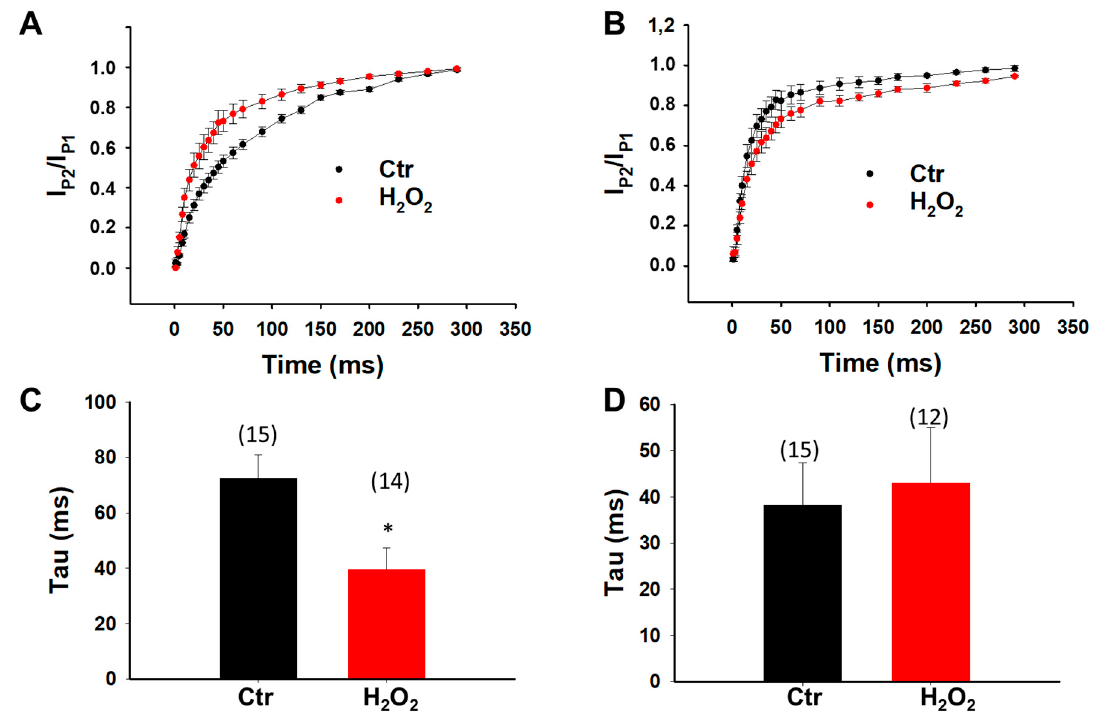
Figure 11. Effects of H 2 O 2 on recovery of sodium channels in hiPSC-CMs from donor and BrS- patient. Cells were treated with vehicle (Ctr) or H 2 O 2 (200 μ M) for 2 h. ( A ) Recovery curves of peak sodium channel currents (I Na ) recorded in hiPSC-CMs from the D2 healthy donor. ( B ) Recovery curves of peak I Na recorded in SCN10A-hiPSC-CMs. ( C ) Mean values of time constants (Tau) of recovery from inactivation in hiPSC-CMs from D2 healthy donor. ( D ) Mean values of time constants (Tau) of recovery from inactivation in SCN10A-hiPSC-CMs. Numbers given in ( C , D ) represent the number of cells of measurements also for ( A , B ). * p < 0.05 versus Ctr according to t -test for two groups.